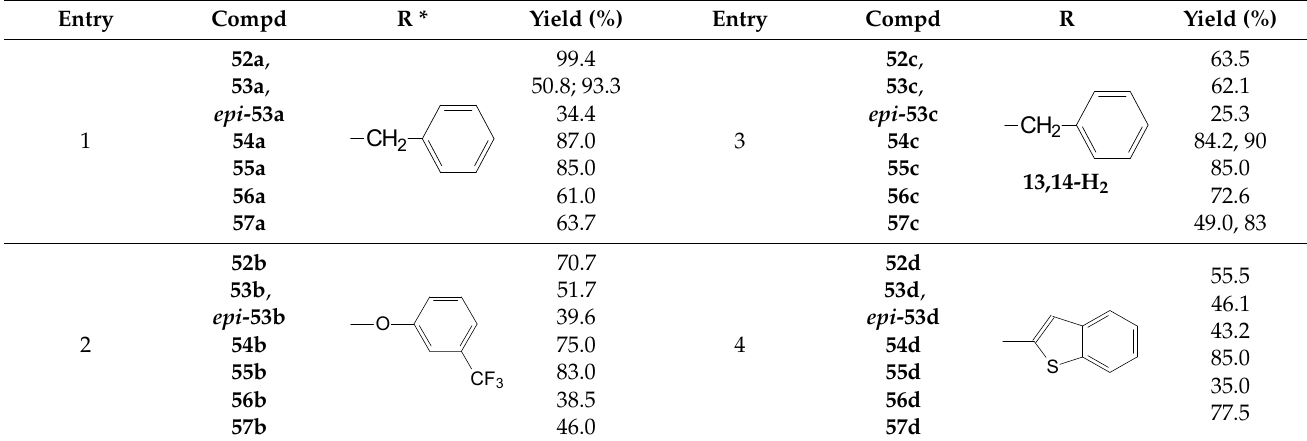
Table 3. Synthesis of 1,9-lactones by RCM [46].